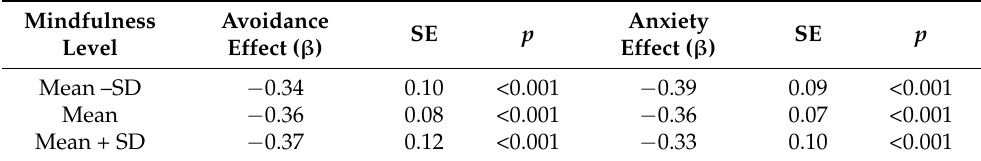
Table 5. Effect of avoidance and anxiety on wellbeing for different levels of